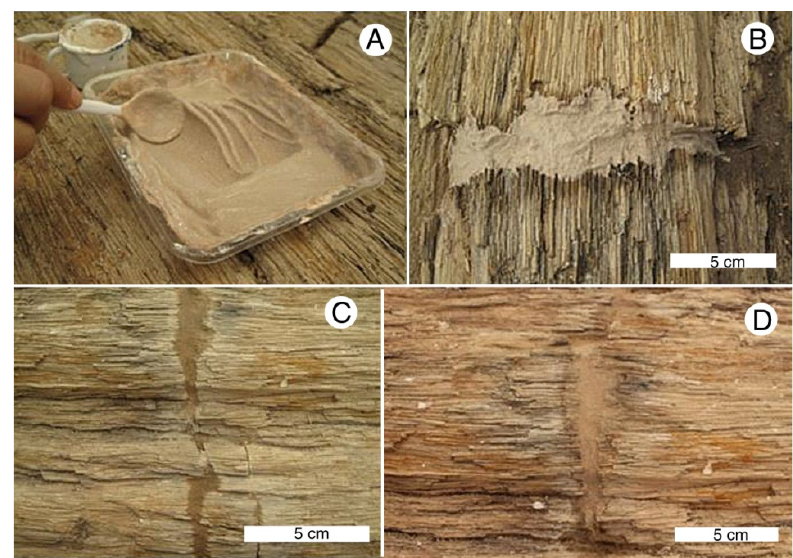
Figure 25. Lime/sand paste tests. ( A ) Mixing lime and sand. ( B – D ) Lime paste used to fill open fractures in Tak fossil wood. Natural or commercial pigments can be used to tint the mixture to provide an approximate color match.